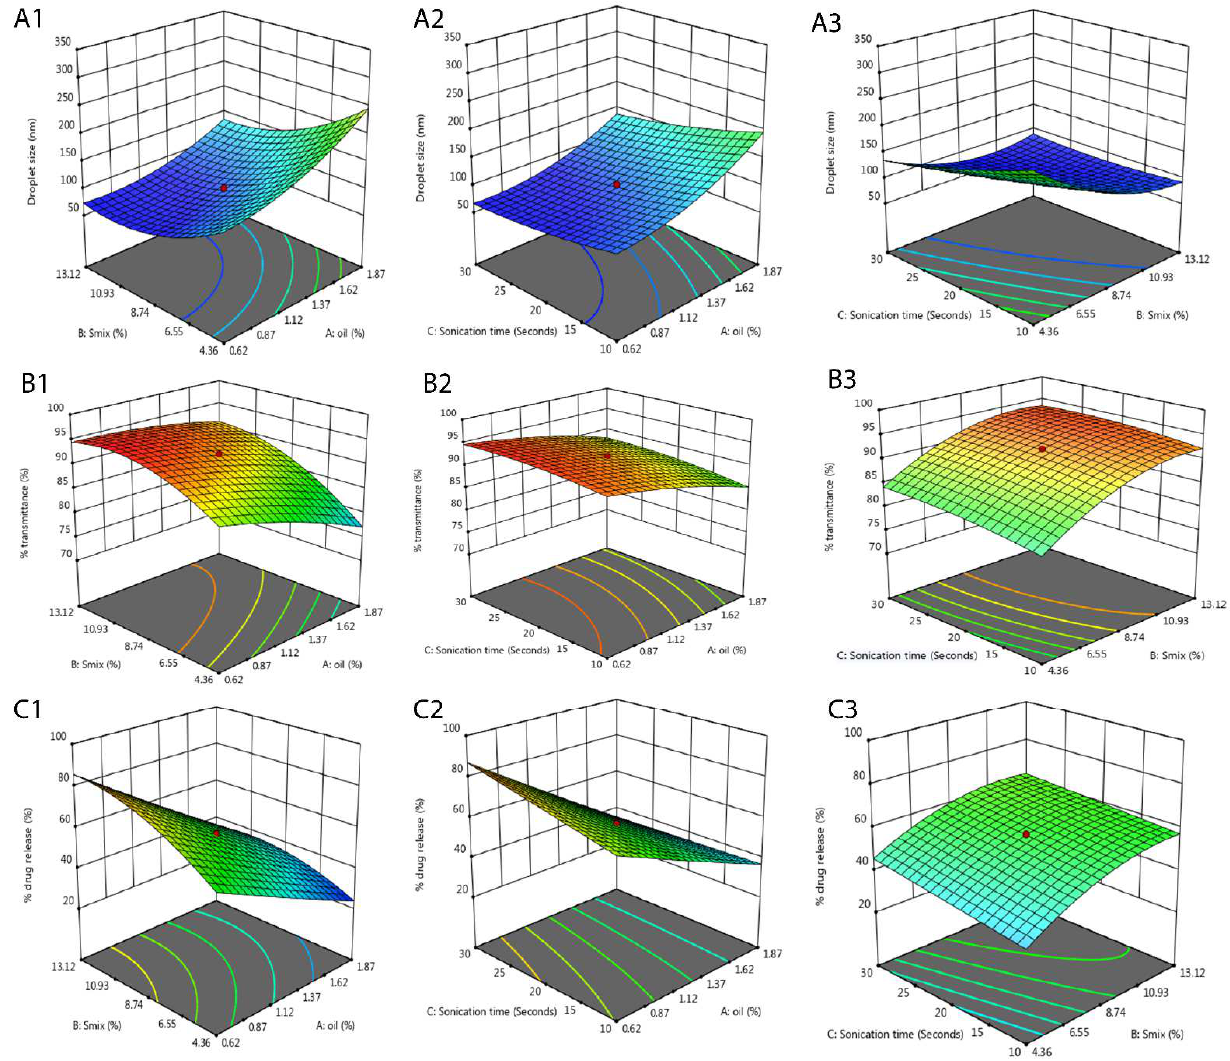
Figure 4. Three-dimensional surface plots depicting the interaction effects of independent variables on droplet size ( A1 – A3 ), % transmittance ( B1 – B3 ), and % CDR ( C1 – C3 ). By Equation (2) and Figure 4B, the % transmittance of the formulation was reduced with an increase in the concentration of oil, but it increased with an increase in the concentration of the S mix and sonication time (Figure 4(B1–B3)). The combination of oil*S mix and oil*sonication time possessed a positive impact whilst the S mix *sonication time possessed a negative impact on % transmittance. The ANOVA analysis and model summary statistics for the experimental results exhibited a greater R 2 of 0.9949 for quadratic Equation (2).